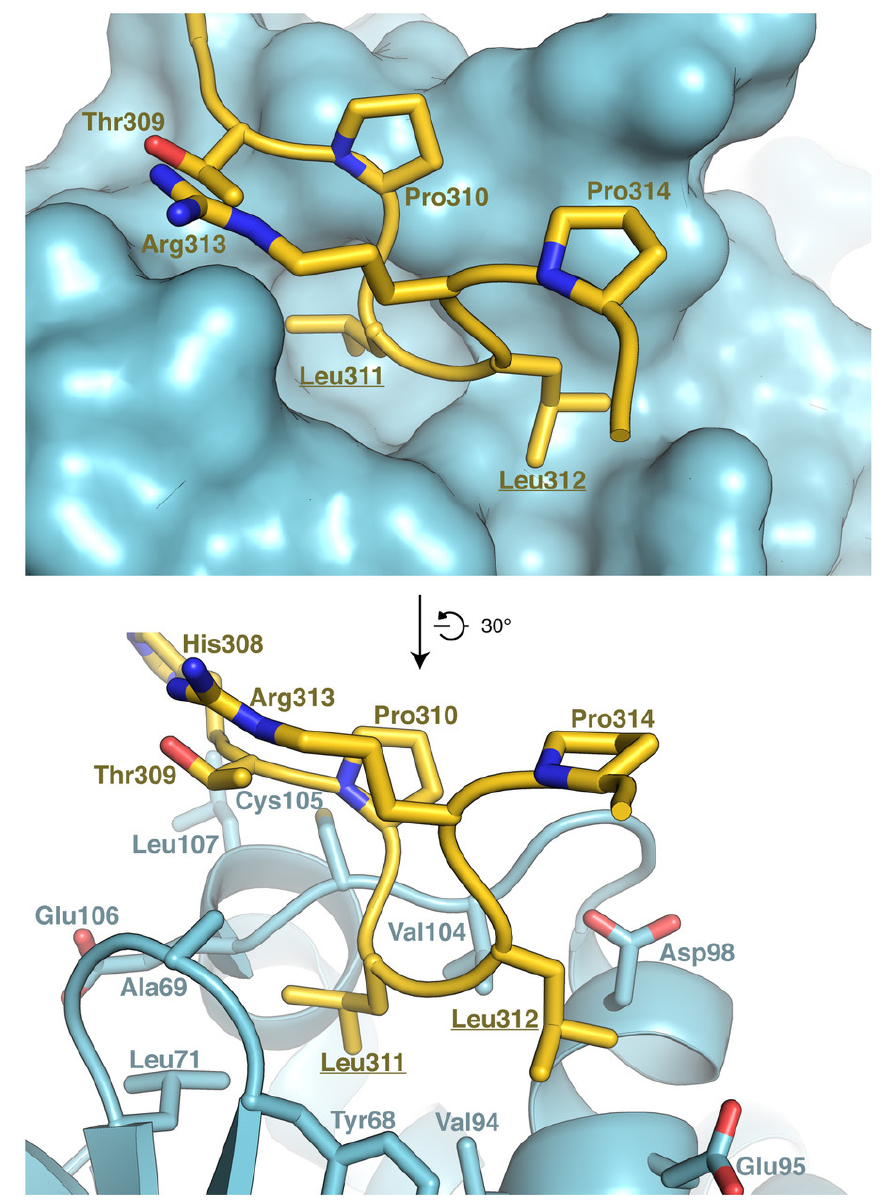
Figure 5. Predicted structure of a complex between AP3S1 and RNF13. The interaction between RNF13 in yellow and AP3S1 in blue was predicted using AlphaFold. Top panel shows RNF13 in sticks and AP3S1 is surface representation. Bottom panel shows RNF13 and AP3S1 in stick representation. In both panels, the two leucine residues which are mutated in DEE73 are underlined. The residues of RNF13 that do not interact with AP3S1 were omitted from the figure for clarity.